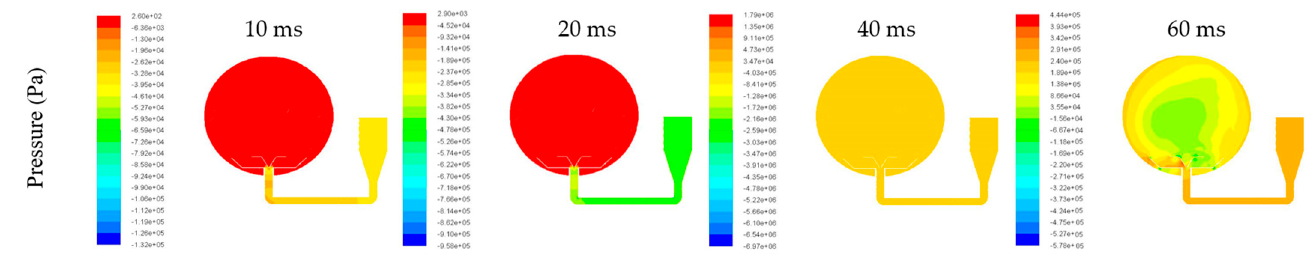
Figure 8. Explosion pressure profile after ignition for 250 g/m 3 Mg/air mixture.